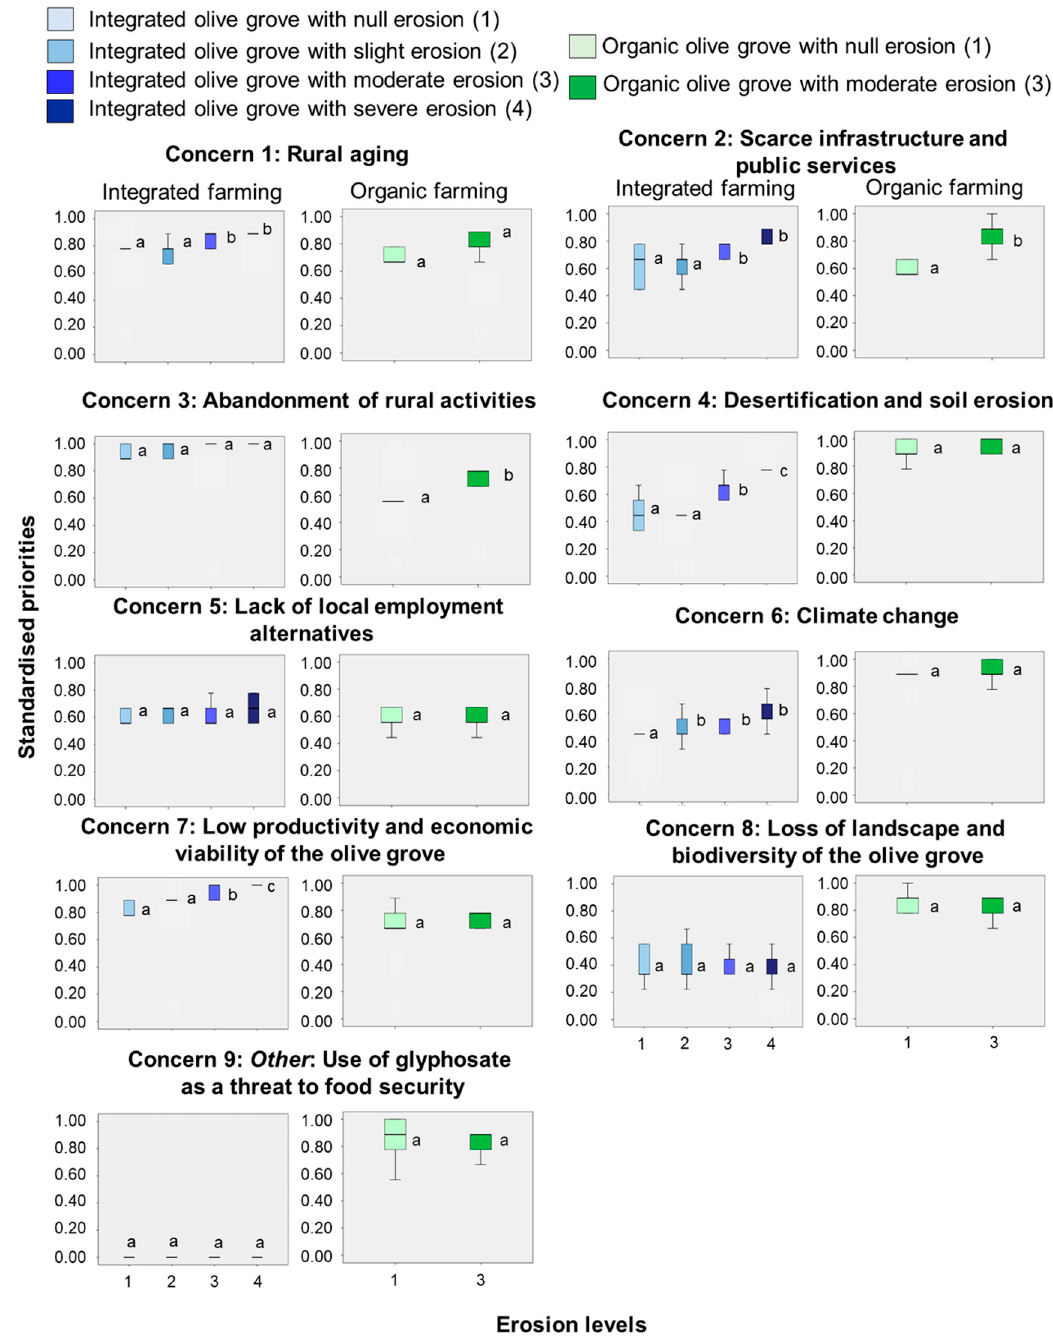
Figure 4. Boxplots showing the results of Tukey’s post-hoc analysis and the Kruskal–Wallis test for each concern evaluated in the integrated and organic olive groves according to their erosion levels. The letters inside each boxplot, indicate the classification groups generated to establish similar categories to each objective.